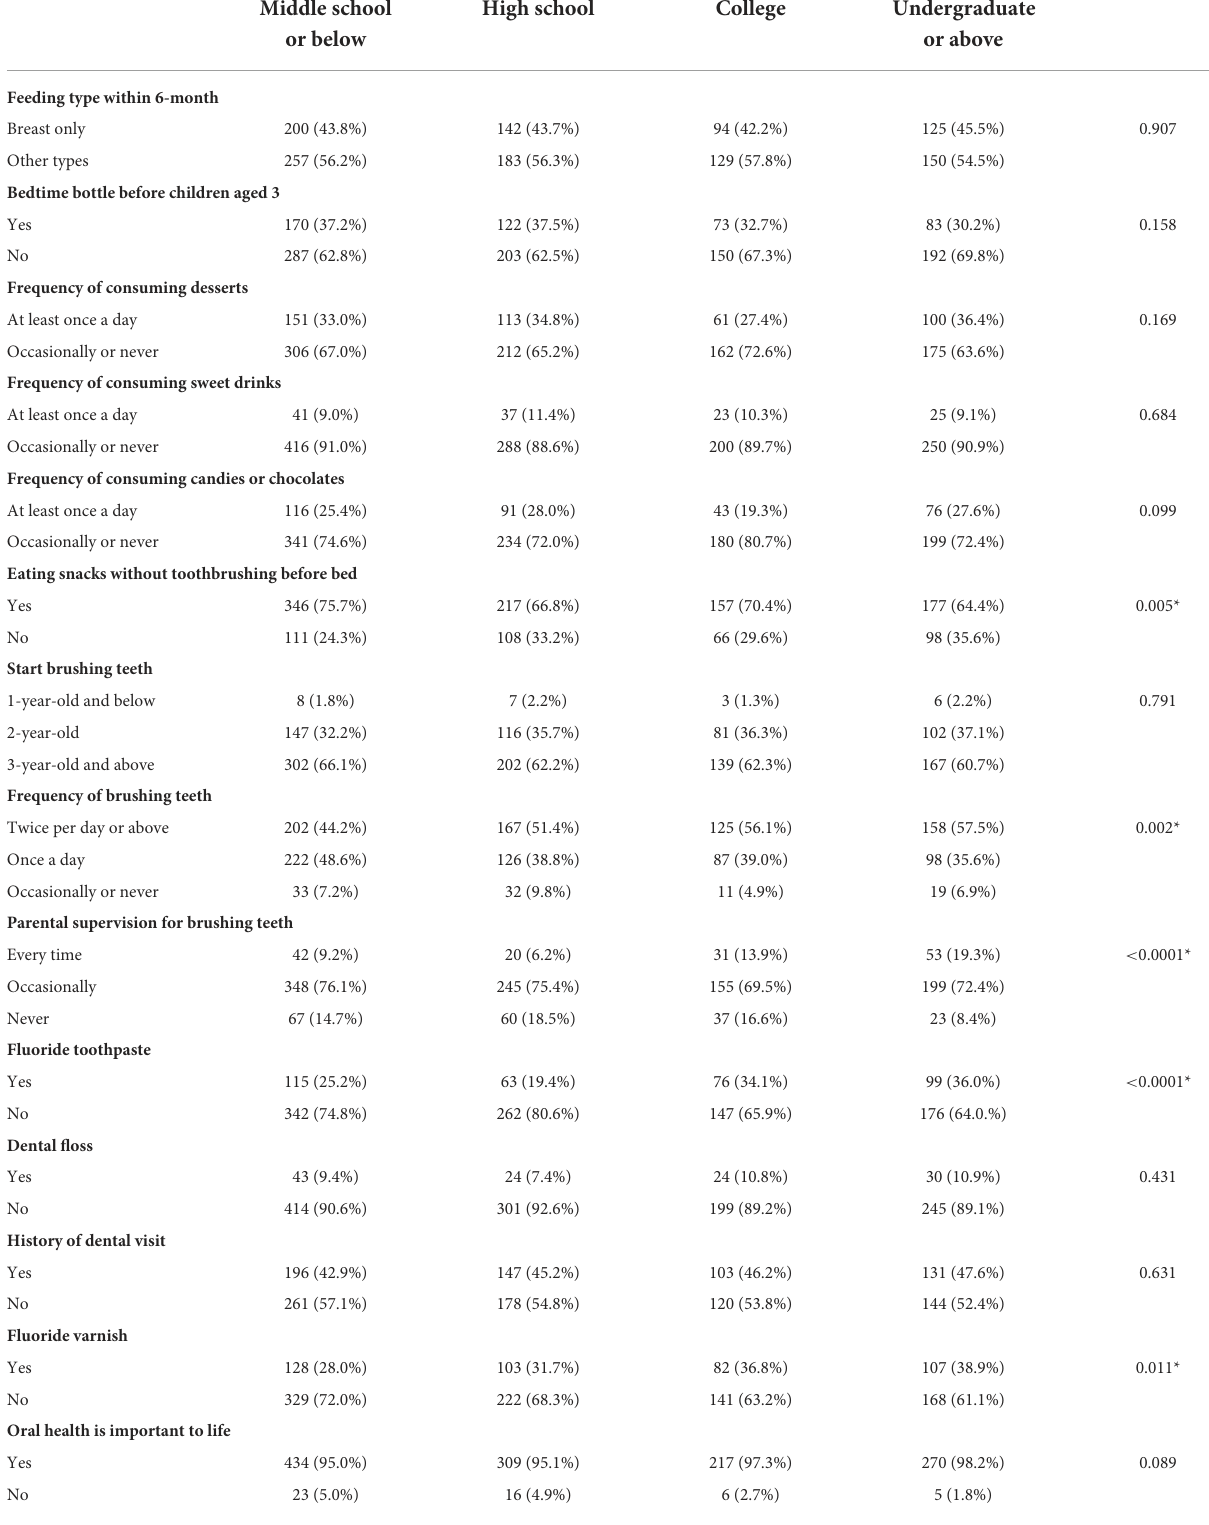
TABLE 5 Parental education level and different variables ( N =